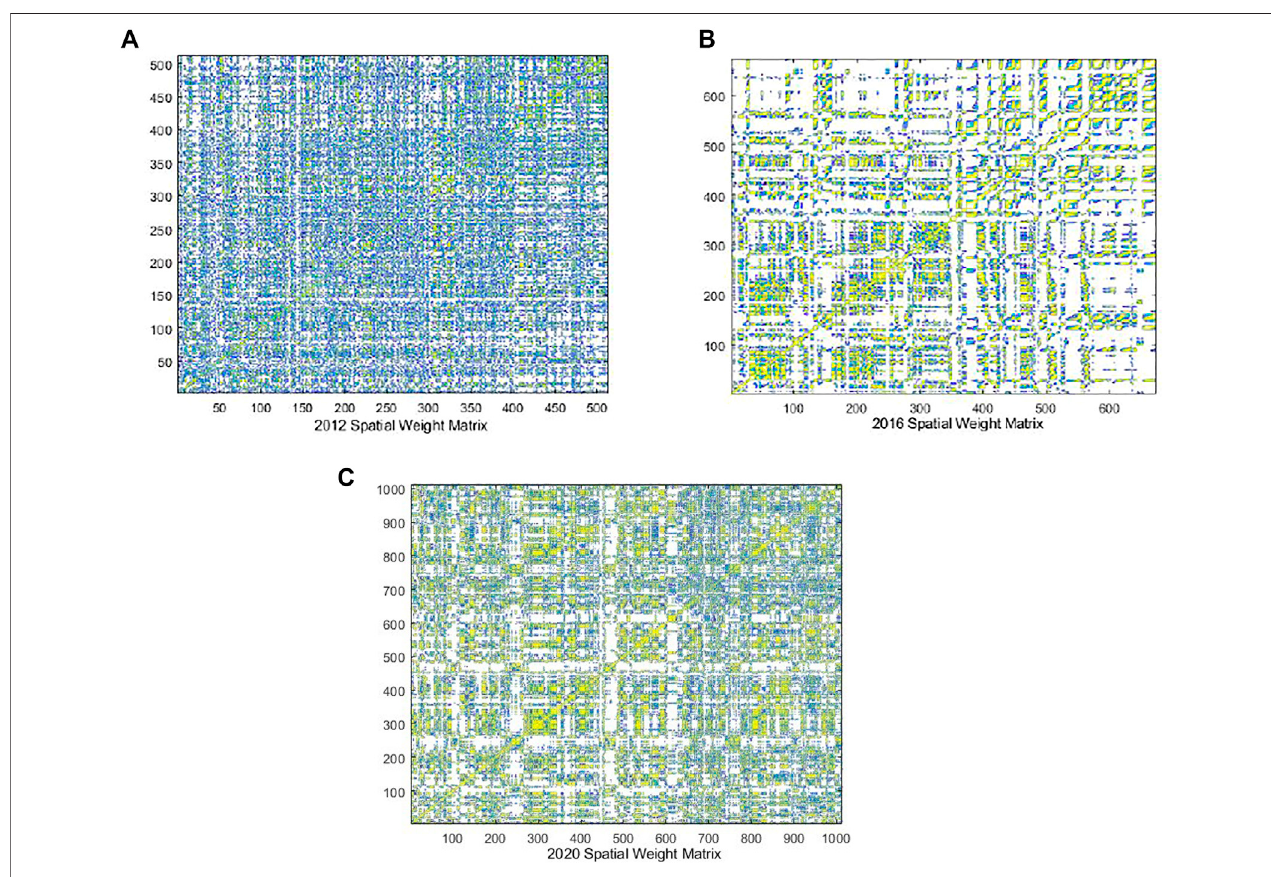
FIGURE 4 | Gaussian spatial weight matrix of Changsha house prices in 2012, 2016, 2020.